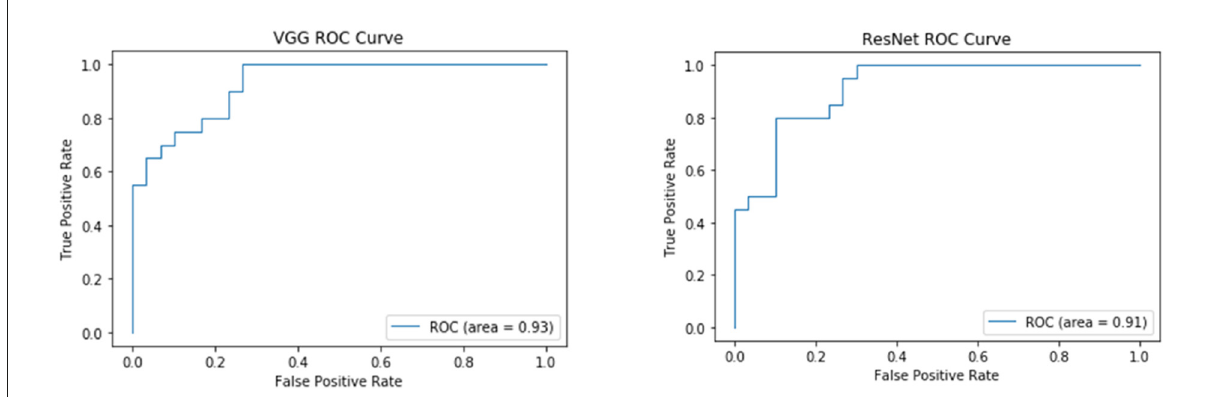
FIGURE4 ROC curve of the VGG and ResNet models. The left panel shows the VGG ROC curve. The right panel is the ResNet ROC curve.